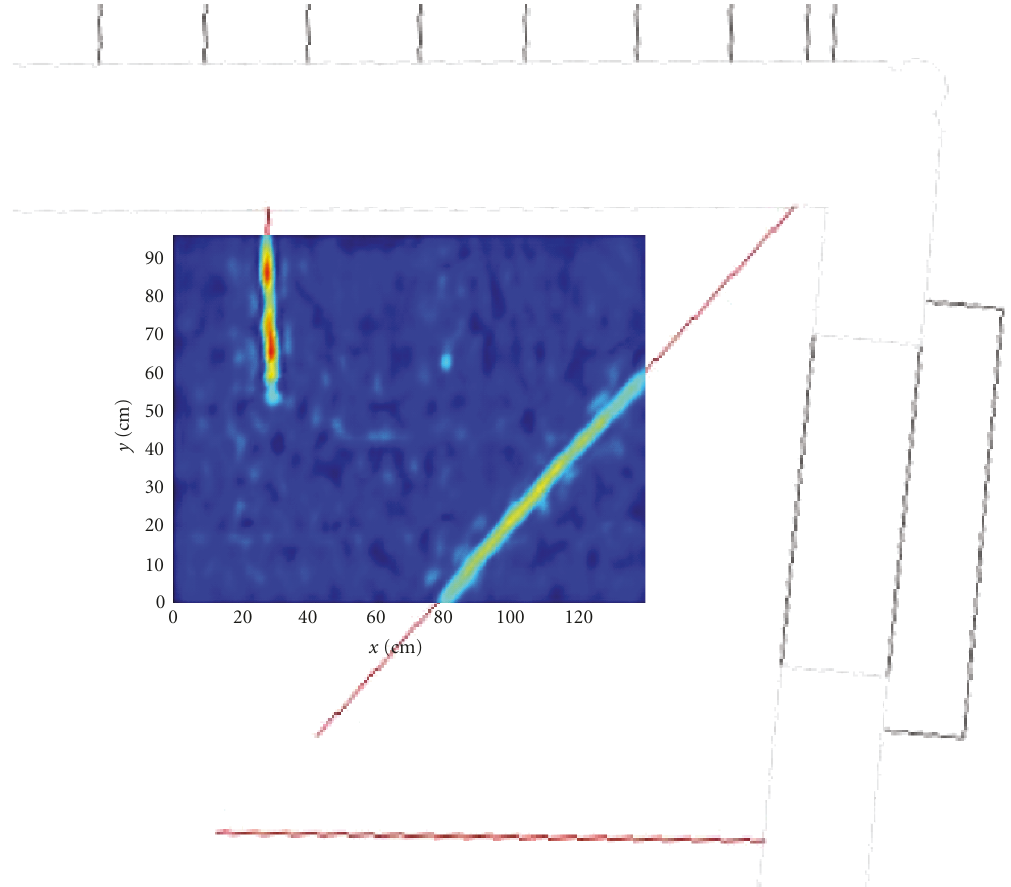
Figure 9: Depth slice at 12.5 cm below the floor surface extracted from a 3D radar survey performed with a 2-GHz antenna in proximity of a building corner of a historical palace in Venice. Data were processed with the two-step 3D migration algorithm. Two fiube (one coming from the building corner) appear in the radar